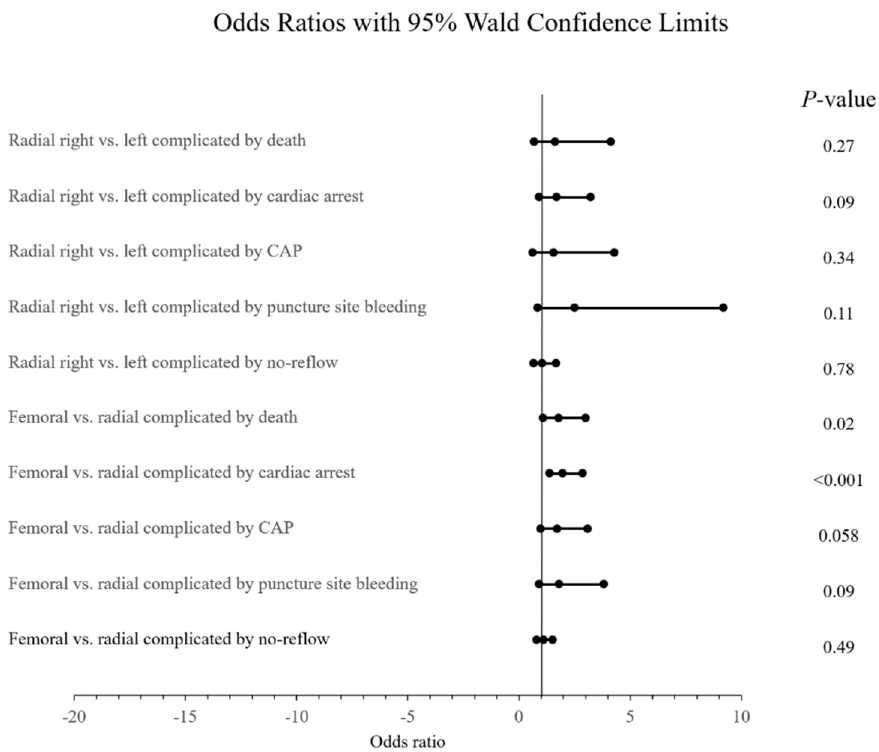
Figure 3. Percentage of PCIs performed on individual vessels depending on the type of vascular access in patients after CABG operation and treated with PCI: ( A ) Overall group; ( B ) Femoral approach; ( C ) Radial approach; ( D ) Left radial approach. Cx = circumflex branch; LAD = left anterior descendent branch; LMCA = left main coronary artery; L/RIMA = left/right internal mammary artery; RCA = right coronary artery; SvG = saphenous vein graft.